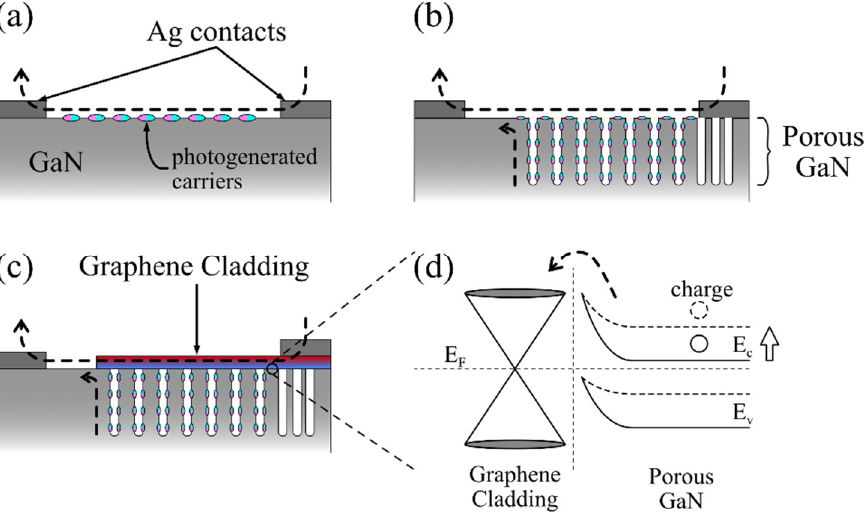
Figure 7. Suggested sensing mechanism of the UV photodetectors based on ( a ) as−received GaN, ( b ) Pr−GaN, ( c ) both EC− and CG−GaN, and ( d ) band diagram illustrating the conduction of charges at the graphene/porous GaN heterojunction.